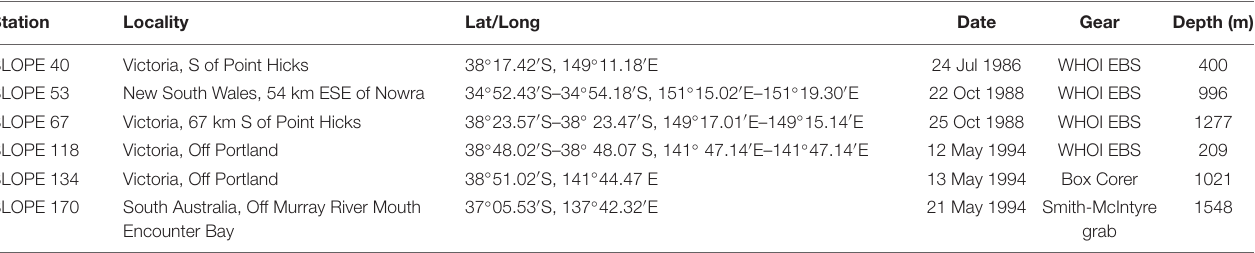
TABLE 1 | Stations where pseudotanaids were recovered off SE Australian collection made on O.R.V. Franklin 1986–1988 and 1994, respectively, Poore et al. (1994); unpublished data.